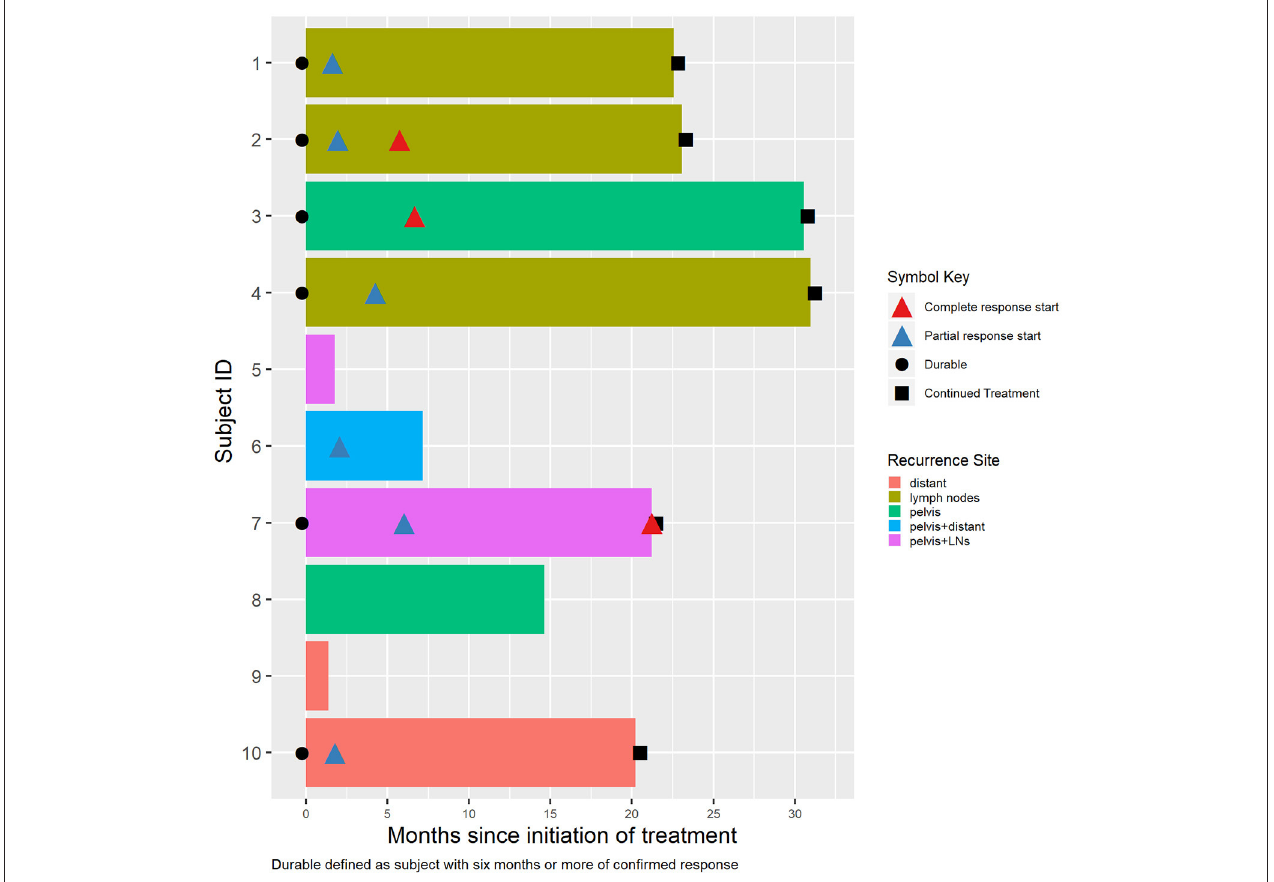
FIGURE 1 | Individual patient disease characteristics, response, and